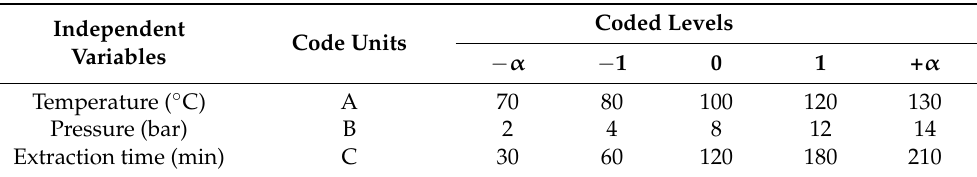
Table 1. Independent variables and their levels for the experimental design of SCG extraction by pressurized hot water